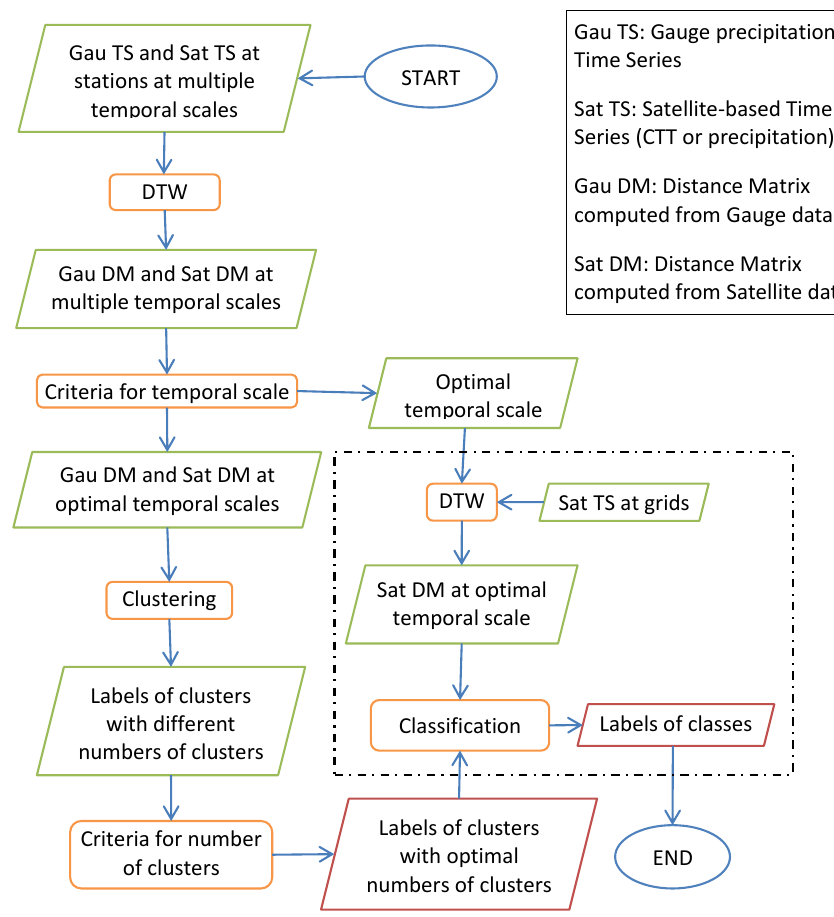
Figure 2. Flowchart of the methodology. Red parallelograms are important outputs of the method; i.e., clustering of gauges and classification of grid cells, where labels of classes mean satellite pixels labeled to precipitation regime clusters. For the German case, we conducted the process of classification in the dashed rectangular using both satellite data and gauge data, and then compared the resulting two sets of labels for validation of the